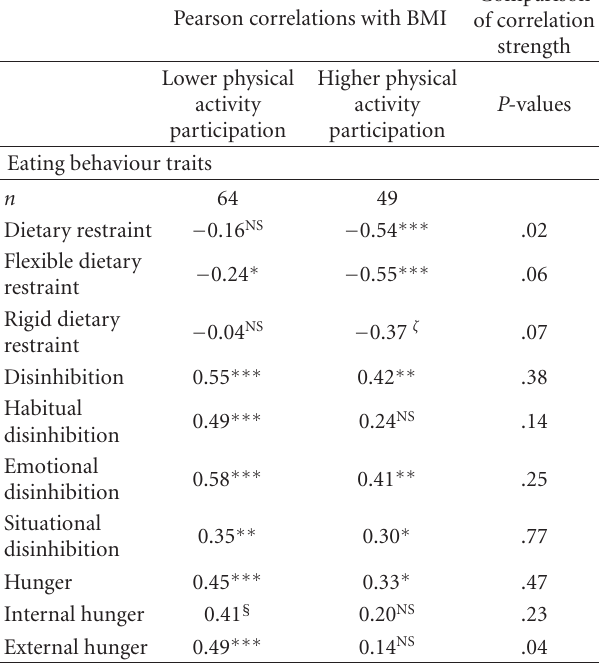
Table 2: Pearson’s correlation coe ffi cients for the associations between eating behaviour traits, and BMI in women characterized by either lower or higher physical activity participation.